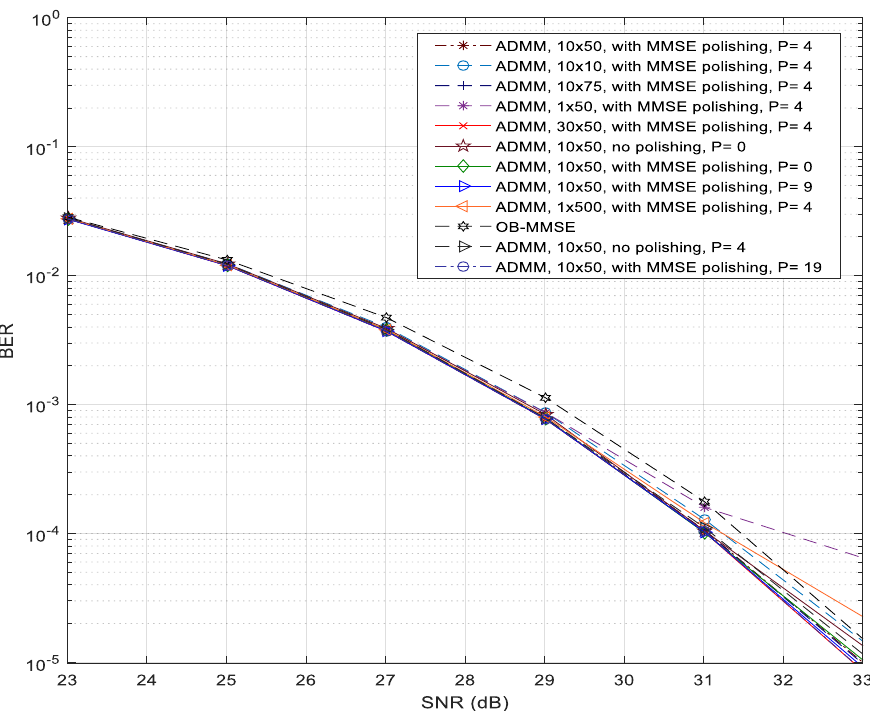
Figure 4. BER performance of ADMM in a MU-MIMO scenario with N tx = 255, N rx = 10, N u = 15, N s = 17 and N a = 2, 1024-QAM.